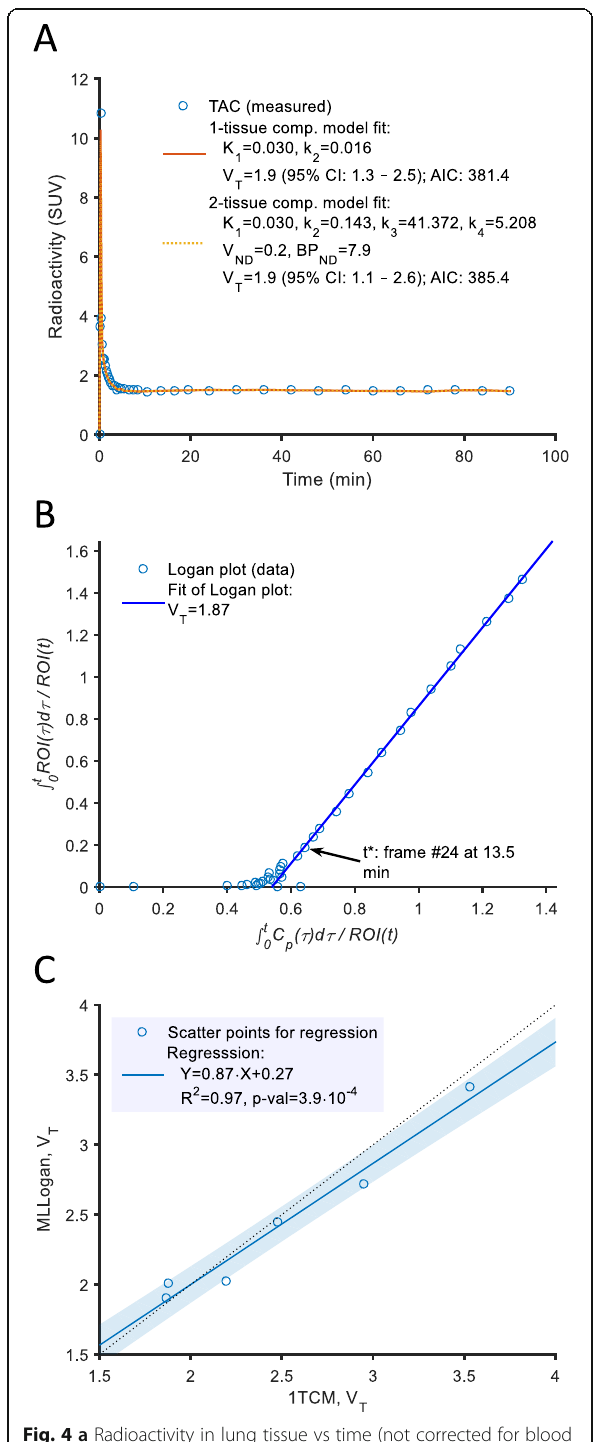
Fig. 4 a Radioactivity in lung tissue vs time (not corrected for blood volume) after I.V. injection of [ 11 C]VC-002 in subject #1 and 1TCM, 2TCM fits. b Illustration of Logan ’ s linear graphical analysis for subject #1 (1st PET). c Regression of V T parameter estimates from MLLogan vs.